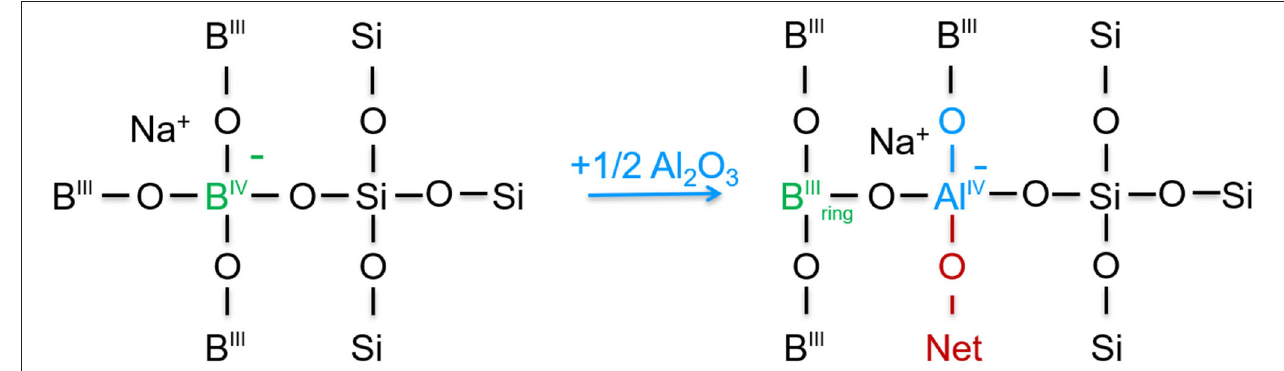
FIGURE 9 | Structural change upon ½ Al 2 O 3 addition in the NBS2 sodium borosilicate glass. The ½ O is shared with the network Net represented in red. The B IV changed to a B III ring represented in green